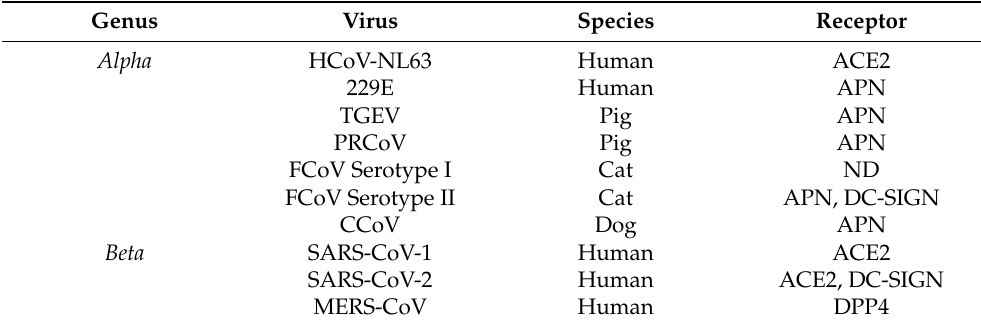
Table 1. List of known alpha- and betacoronavirus cellular receptors. Genus Virus Species Receptor Alpha HCoV-NL63 Human ACE2 229E Human APN TGEV Pig APN PRCoV Pig APN FCoV Serotype I Cat ND FCoV Serotype II Cat APN, DC-SIGN CCoV Dog APN Beta SARS-CoV-1 Human ACE2 SARS-CoV-2 Human ACE2, DC-SIGN MERS-CoV Human